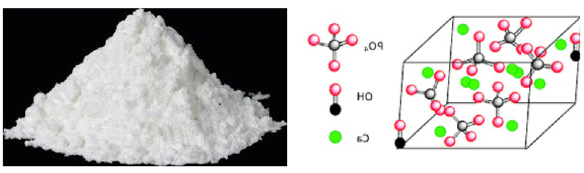
Fig. 2 Hydroxyapatite a Powder from cow bone, b Lattice [21,